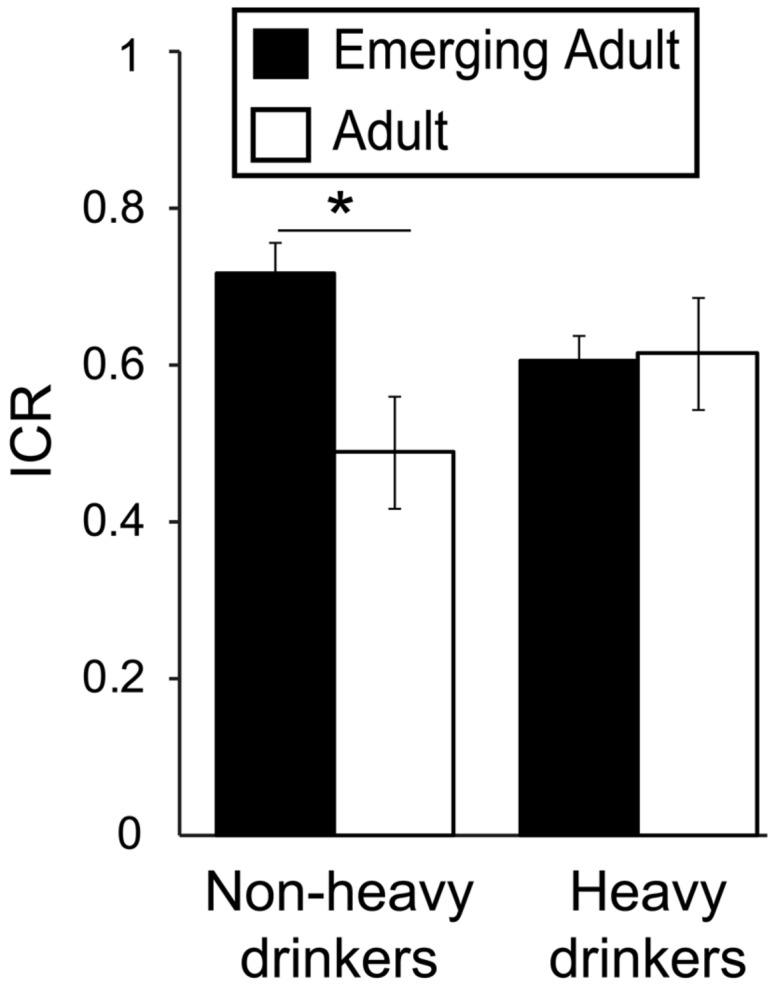
Interacting effects of age and alcohol use on Now bias. Plot depicts the ratio of immediate reward choices (ICR) in the delay-discounting task as a function of drinking (heavy/non-heavy) and age (adult/emerging adult) groups, demonstrating a significant age∗drinking interaction [F(1,217) = 5.17, p = 0.024, η2 = 0.023]. This finding reflects the fact that among non-heavy drinkers, ICR was significantly higher in emerging adults relative to adults [F(1,91) = 8.46, p = 0.005, η2 = 0.085], but among heavy drinkers, ICR did not differ between age groups. AUDIT, Alcohol Use Disorders Identification Test. ∗p < 0.05.